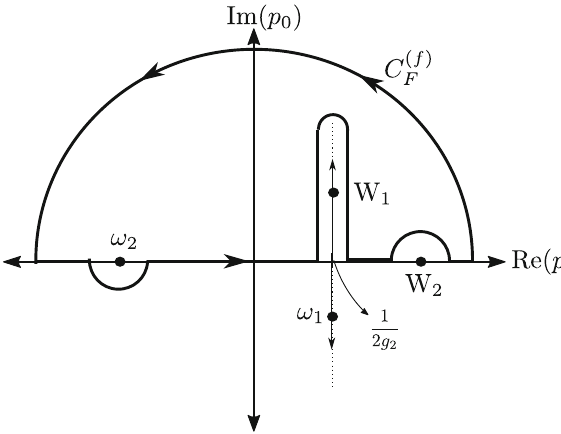
( f ) Fig. 2 The integration contour C for the fermion propagator which F is defined to round the negative pole from below and the positive poles from above. At higher energies than 1 /( 4 g 2 ) , the two solutions ω 1 and W 1 become complex and move in opposite directions along the imagi- narylinestartingat1 /( 2 g 2 ) ,wedeformthecontourcontinuouslyavoid- ing any crossing or singularity with the poles